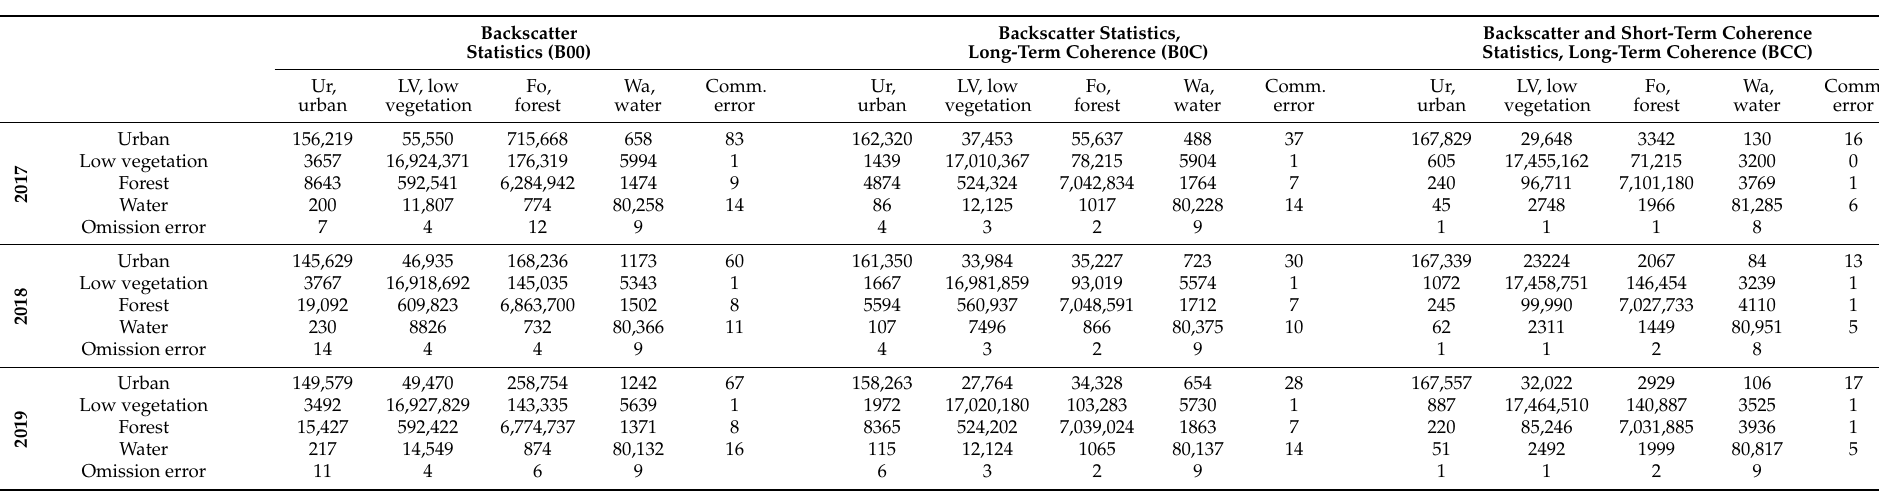
Table A1. Temperate site confusion matrices by year and feature set (Reference > columns; Classified > Rows) compared to the land cover validation dataset (comm. stands for commission). Backscatter Statistics (B00)